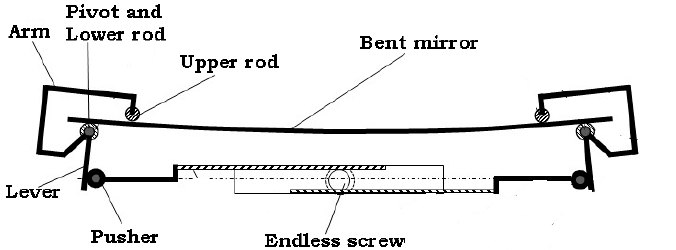
Figure 6. Upper view of the bent mirror.